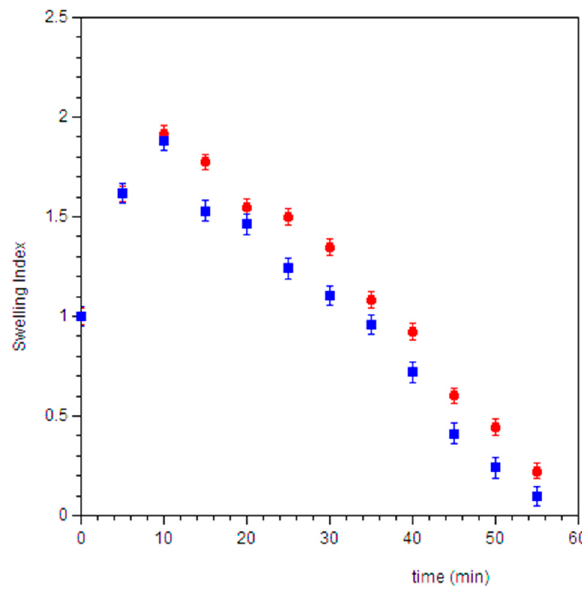
Figure 8. Swelling index ( AFA100, AFA300) measured as the ratio between the weight of the swollen film and dry film vs. time. Values are presented as means ± SE (n = 6).